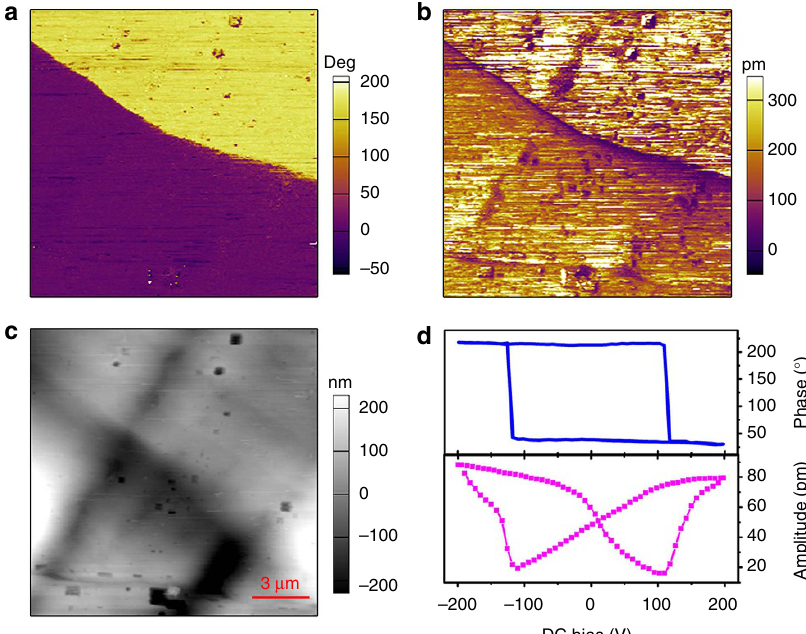
Figure 6 | Domain structures observed for an as-grow crystal of 1. ( a )The vertical PFM phase image. ( b ) The vertical PFM amplitude image. ( c ) The topographic image of the crystal surface. ( d ) Phase and amplitude signals as functions of the tip voltage for a selected point, showing local PFM hysteresis